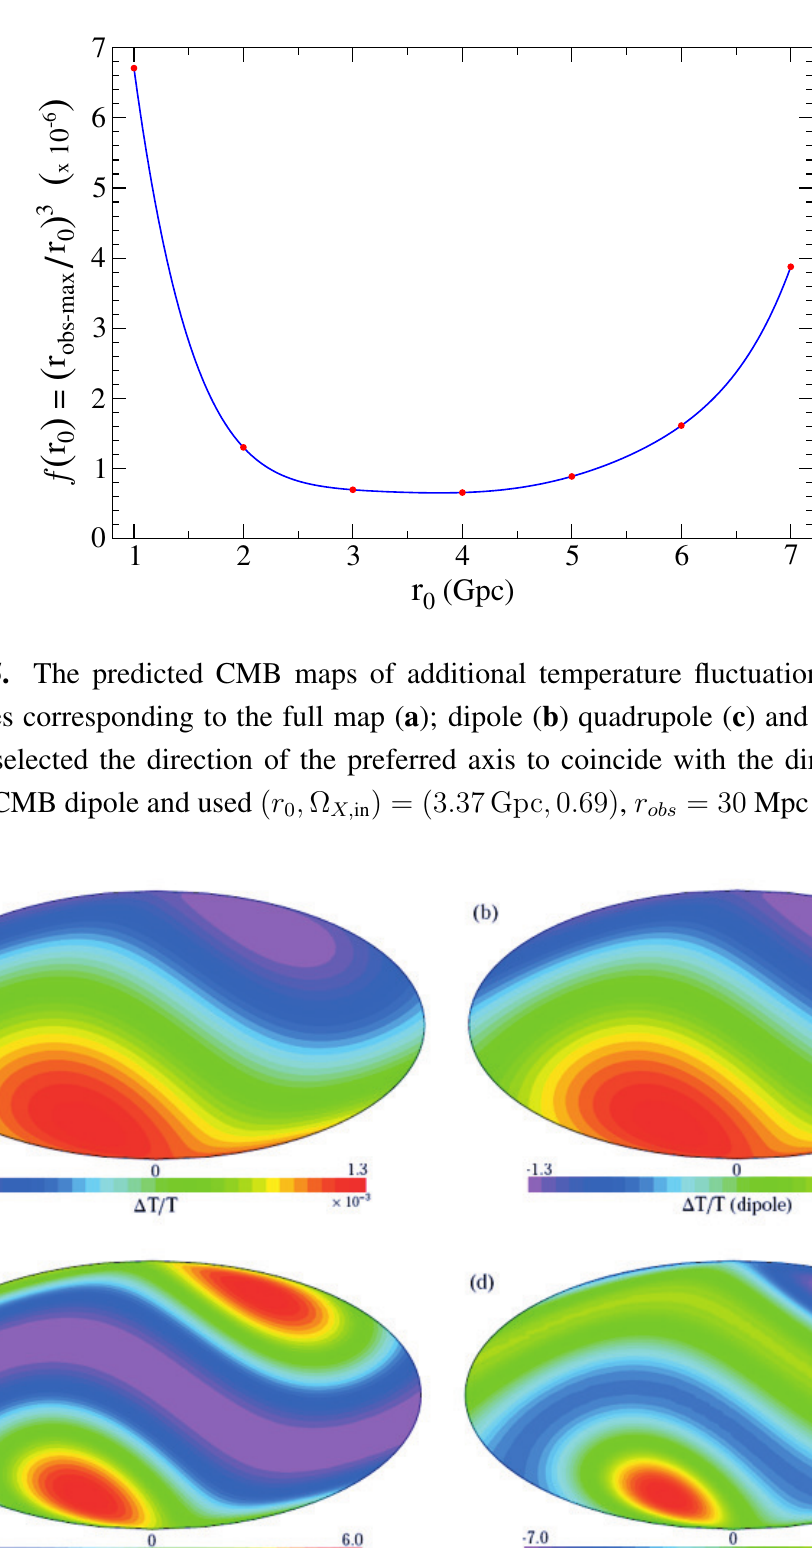
) ≡ ( r obs − max ) 3 where the observer needs to be 0 r 0